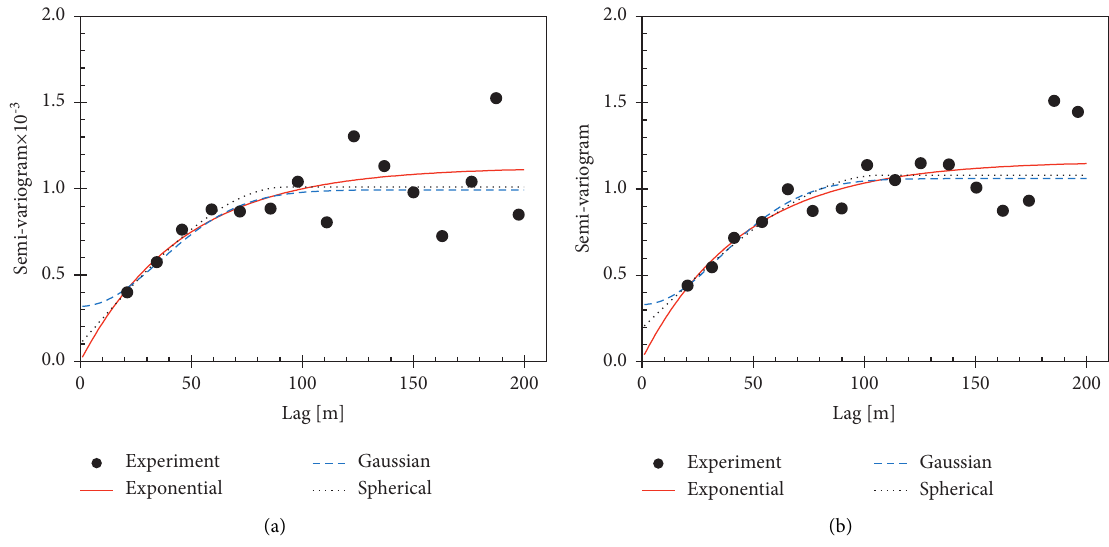
Figure 4: Experimental semivariograms in the horizontal plane fitted with three theoretical semivariograms such as exponential, Gaussian, spherical models: (a) Original or raw bearing capacities: and (b) Normal score transformed bearing